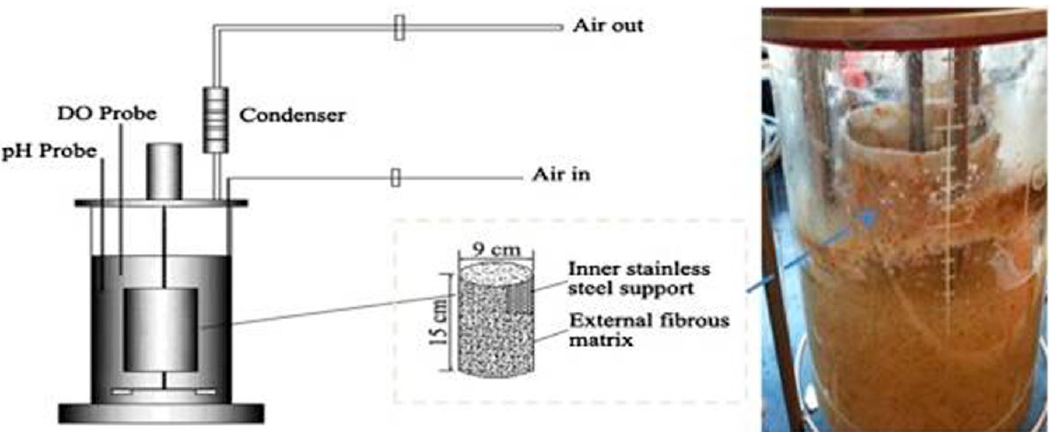
Figure 1. Higher β -1,4-glucosidase production by Aspergillus niger grown on wheat bran and glycerol was obtained in a rotating fibrous bed bioreactor (RFBB), because of better morphology control and mass transfer (adopted with permission from the authors of[59]).